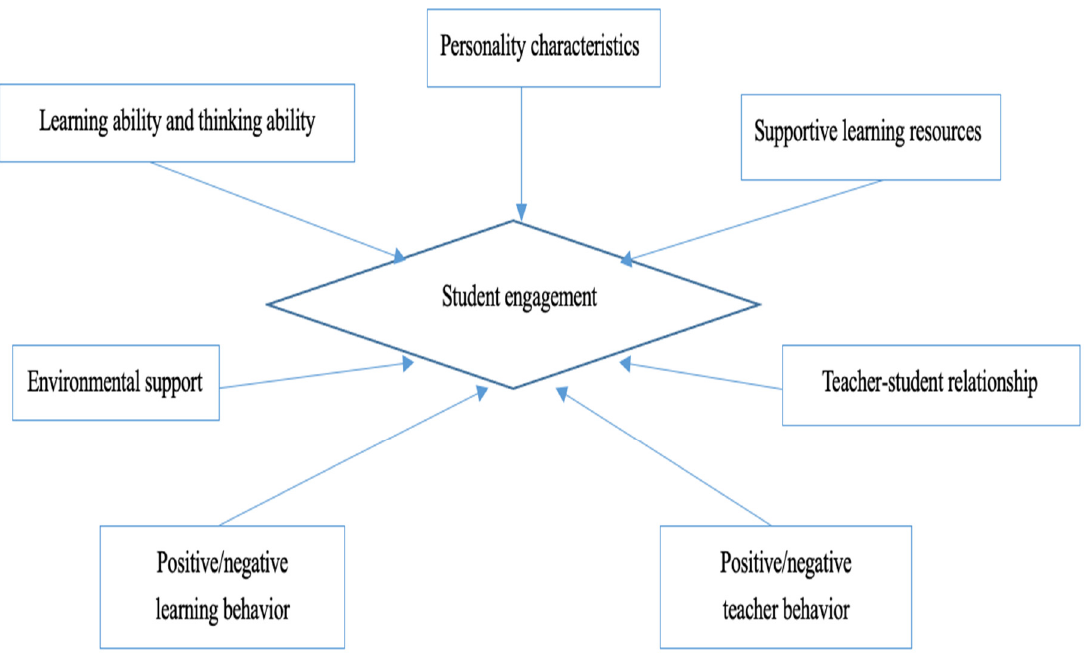
Figure 1. Factors influencing student engagement